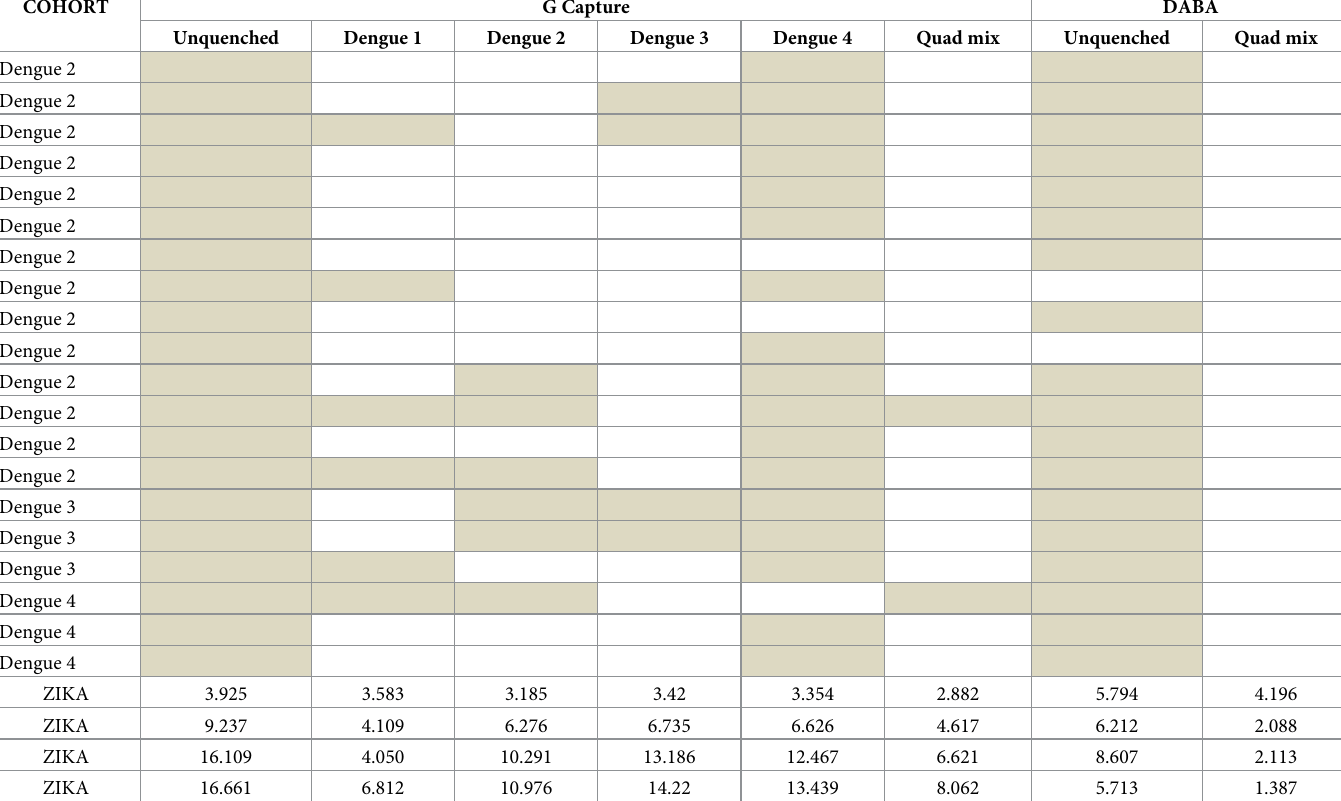
Table 2. Quenching of non-specific antibody reactivity using a panel of Dengue serotype 1 to 4